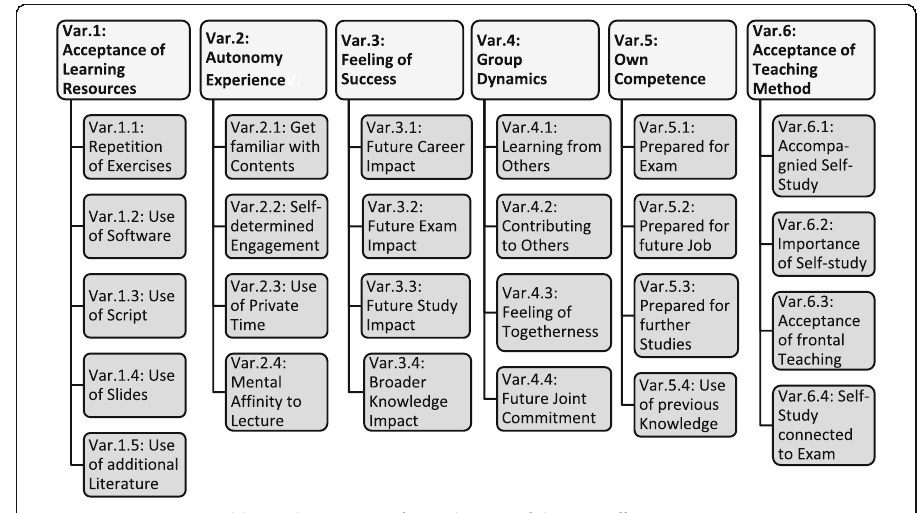
Fig. 2 Overview on variables in the Post-Test for evaluation of the CPR-effect